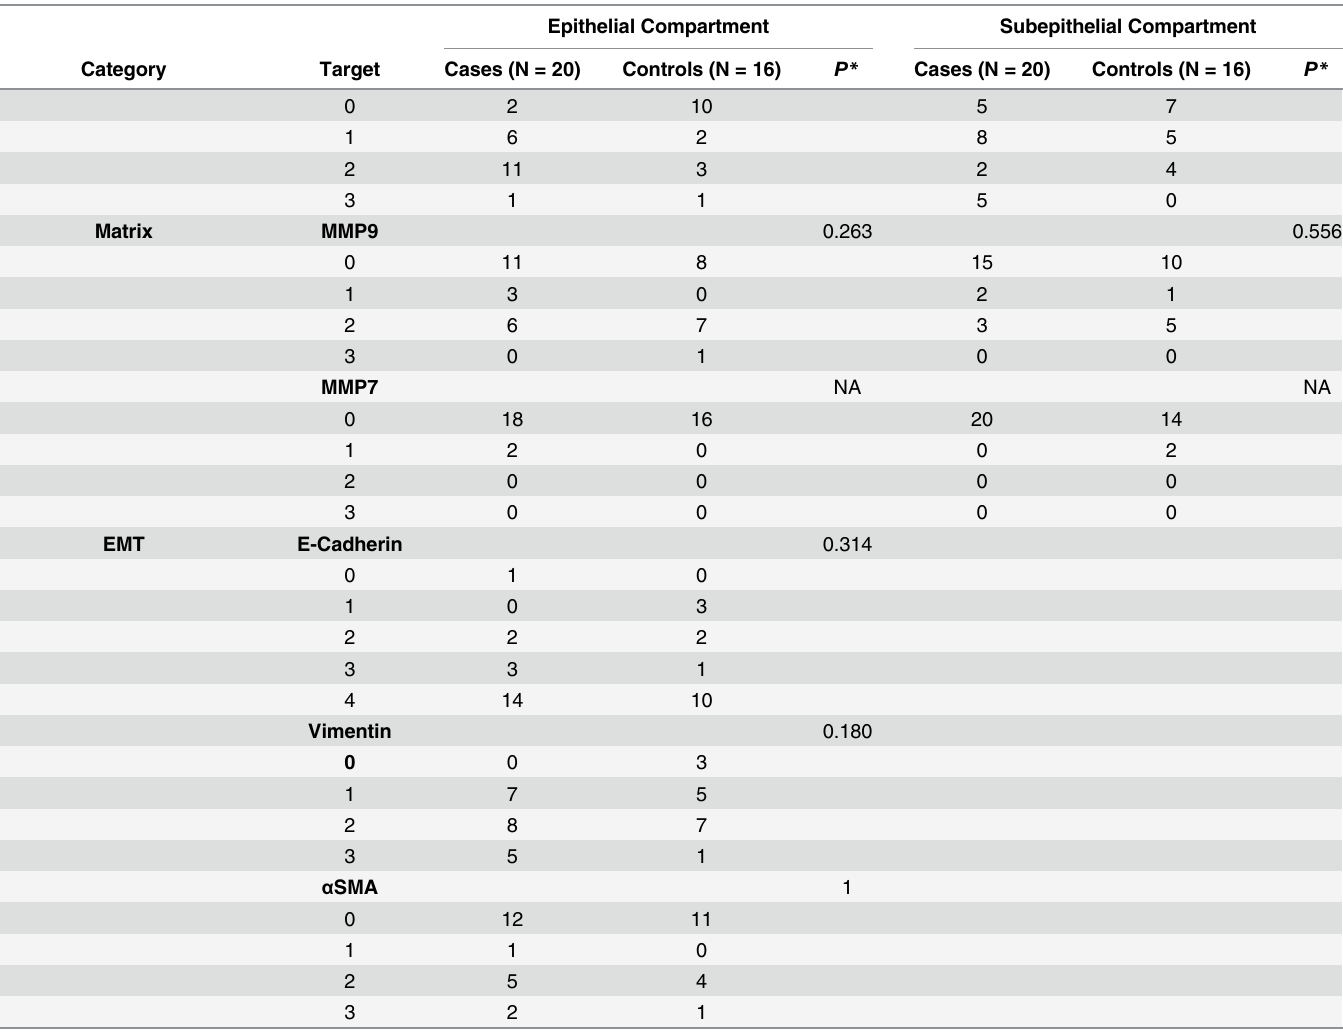
infiltrate (Fig 2C), however, only 5/11 of samples that stained > 0 for IL-1 β had a clinical papil- lary grade > 0. Expression of IL-1 β tended to be higher in the epithelium of TT cases but the difference was not statistically significant. S100A7 expression was significantly higher in the epithelium of TT cases (P = 0.0095). Expression of S100A7 within the epithelium was patchy and in 2 samples expression was local- ized to pseudoglands of Henle (Fig 2E). All controls stained negative for S100A7. Six of the nine samples that scored > 0 for S100A7 had a clinical papillary grade > 0. S100A7 was not detected in the subepithelial tissue in any sample. TGF β 2 expression was slightly greater in the subepithelial tissue of controls (P = 0.037). Four controls were weakly positive (Fig 2H) and one case (papillary grade 3) had